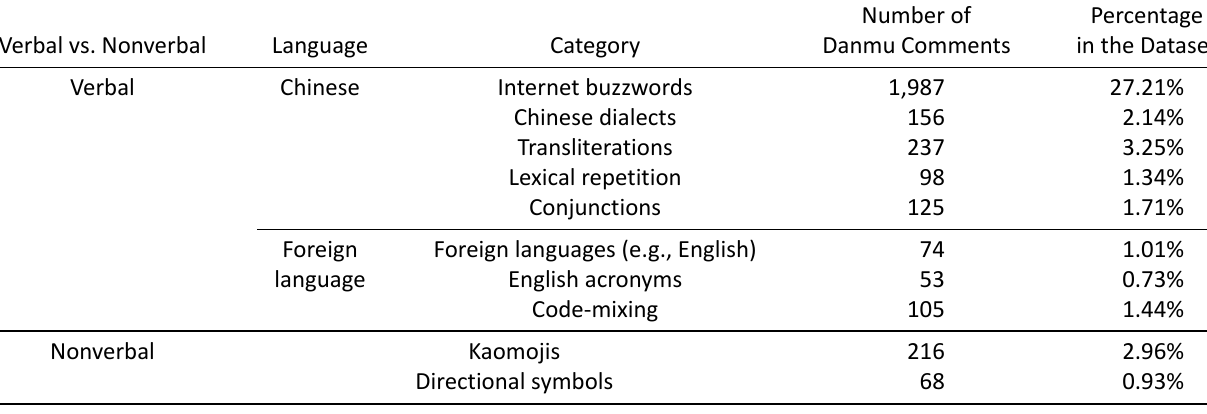
Table 3. Distribution of language type in danmu